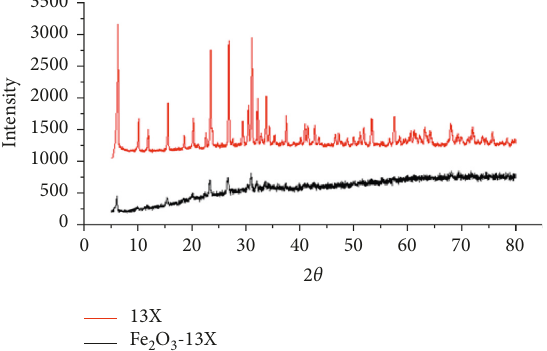
Figure 1: XRD patterns of Fe